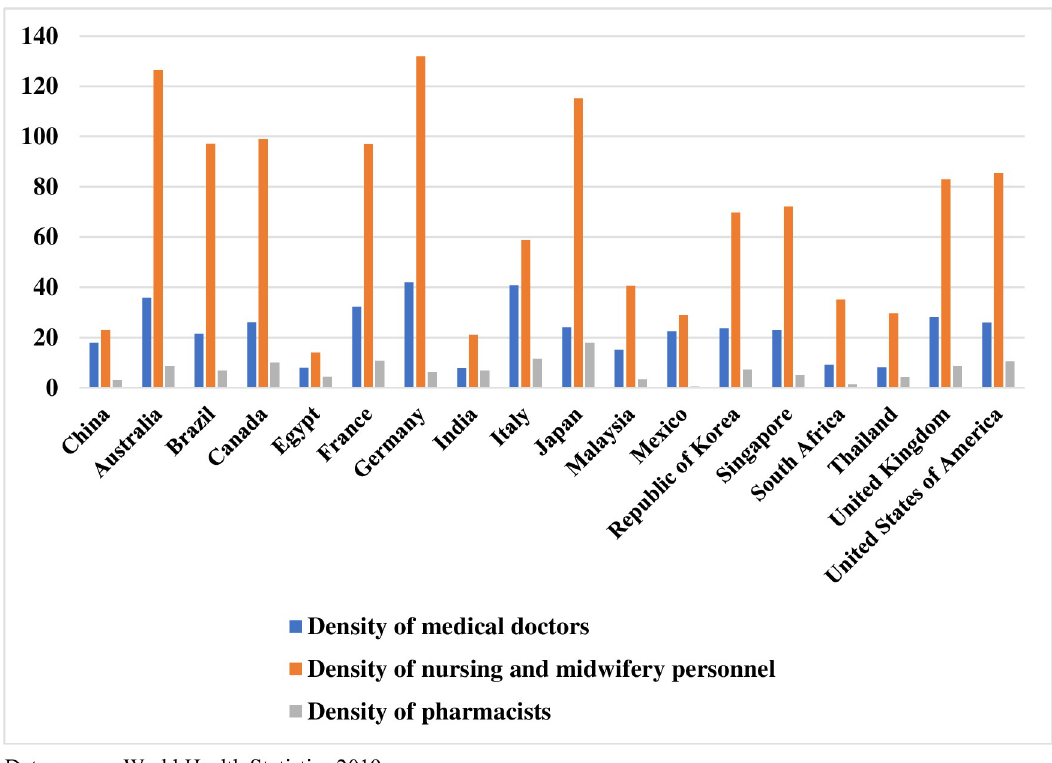
Fig 3. Average density of medical workers (per 10,000 population) for certain countries between 2009 and 2018.